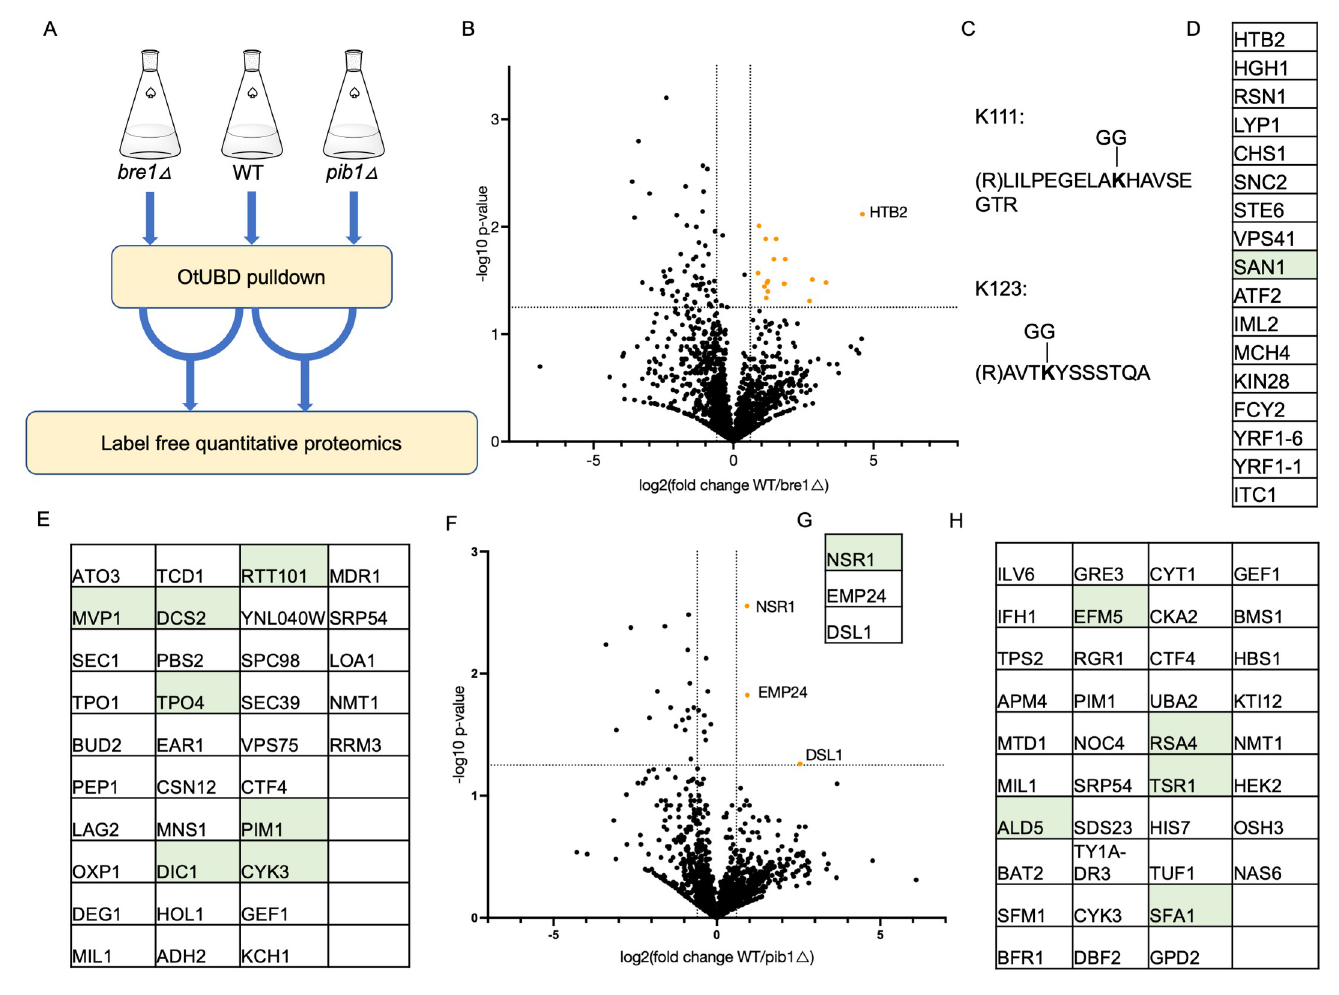
Fig 6. Identification of potential E3 substrates by OtUBD pulldown and label-free quantitation. (A) Scheme for E3 substrate identification using OtUBD pulldown and quantitative proteomics. WT and E3 deletion ( bre1 Δ and pib1 Δ ) yeast strains were subjected to OtUBD pulldowns following extract denaturation. The eluted proteins were then analyzed by label-free quantitation. (B) Volcano plot comparing WT and bre1 Δ samples. Orange dots represent proteins that were significantly enriched in WT samples compared to bre1 Δ samples. Horizontal dashed line indicates p = 0.05. Vertical dash lines indicate relative change of +/ − 1.5-fold. The numeric values supporting this figure can be found in S2 Data. (C) Two different ubiquitylation sites identified on histone H2B (Htb2) in different samples. (D) List of proteins that were significantly enriched in WT samples compared to bre1 Δ samples (orange dots in B). Green color indicates proteins that were previously reported to be stabilized in bre1 Δ yeast. (E) Ubiquitylated proteins detected exclusively in WT but not bre1 Δ samples. Green color indicates proteins previously reported to be stabilized in bre1 Δ cells. (F) Volcano plot comparing WT and pib1 Δ samples. Orange dots represent proteins that were significantly enriched in WT samples compared to pib1 Δ samples. Horizontal dash line indicates p = 0.05. Vertical dash lines indicate relative change of +/ − 1.5-fold. The numeric values supporting this figure can be found in S2 Data. (G) List of proteins that were significantly enriched in WT samples compared to pib1 Δ samples (orange dots in F). Green color indicates proteins that were previously reported to be stabilized in pib1 Δ yeast. (H) Ubiquitylated proteins detected exclusively in WT but not pib1 Δ samples. Green color indicates proteins previously reported to be stabilized in pib1 Δ yeast. WT,